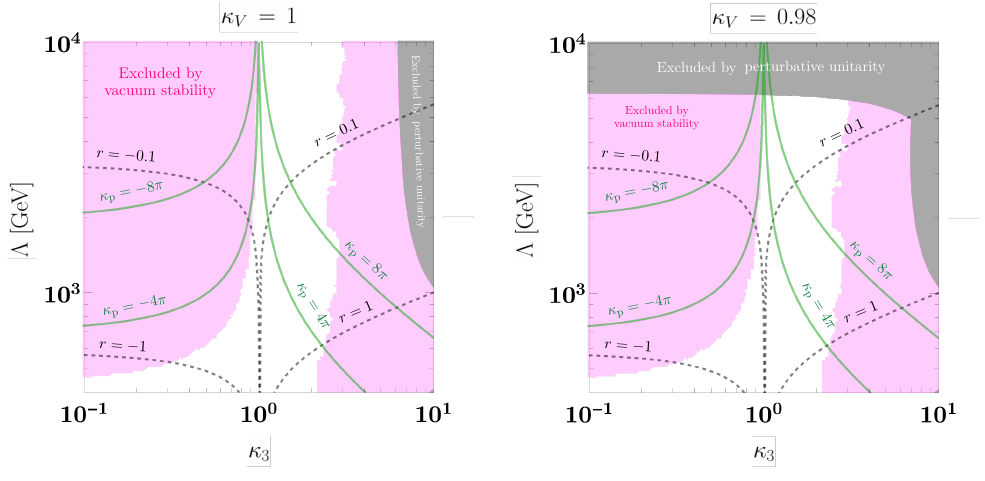
Figure 5 . Similar plots to figure 4. We employ κ 3 as an input parameter instead of r . Black dotted lines are contours of r = − 1 , − 0 . 1 , 0 . 1 , and 1